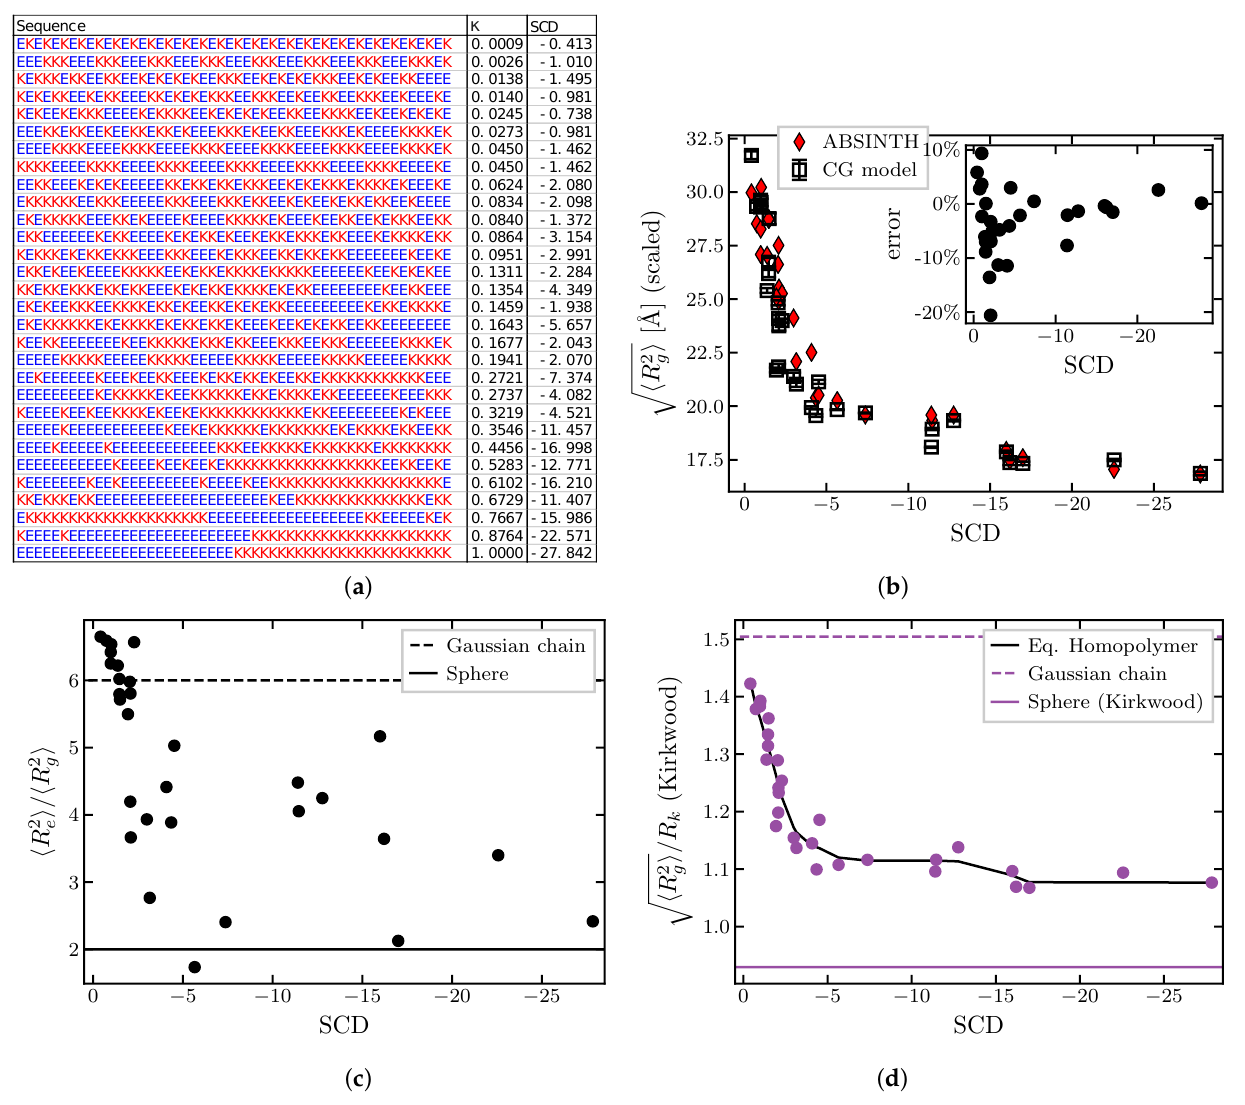
Figure 4. Dimensions of charged polymers. ( a ) Sequences composed of 25 positively and 25 negatively charged amino acids with their corresponding Sequence Charge Decoration (SCD) κ charge pattern parameters; see text. “K” represents positively charged lysine and “E” represents negatively charged glutamic acid. ( b ) Radii of gyration of the sequences. Black symbols: coarse-grained model; red symbols: ABSINTH model. ( c ) Squared ratio of the end-to-end distance to the radius of gyration. ( d ) Ratio of the radius of gyration to the hydrodynamic radius (in Kirkwood approximation). Solid black line is the effective homopolymer representation (see Figure 5). The dashed lines correspond to the Gaussian chain predictions, the solid lines correspond to a uniform